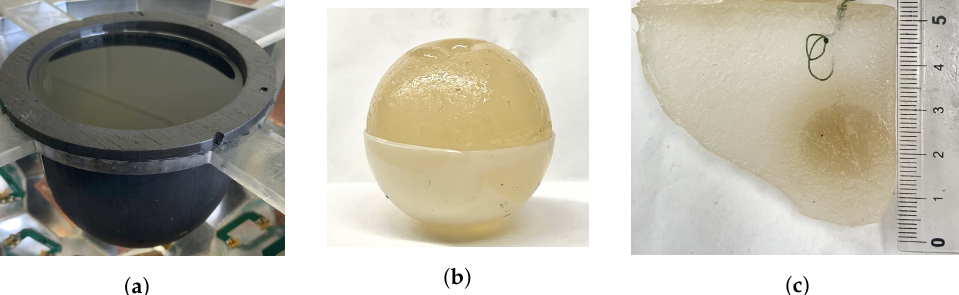
Figure 3. Dual-mode breast phantom components. ( a ) Skin and fat. ( b ) Spherical tumour in the bottom half of the mould. ( c ) Cross-section of fibroglandular with embedded ellipsoidal tumour. Ruler in cm. Table 1. Ingredients and measured physical properties of dual-mode breast phantom materials. Target values are in